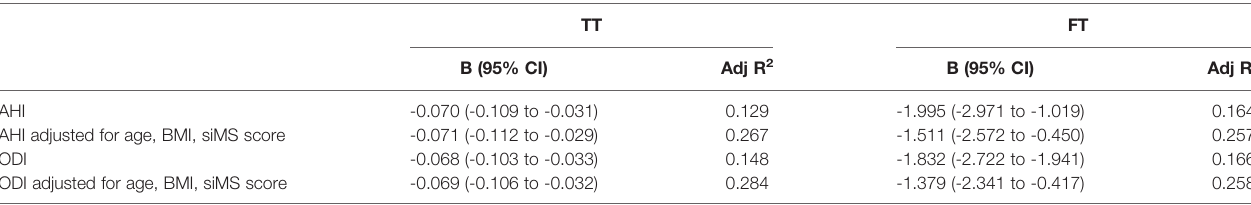
TABLE 4 | Multiple linear regression model for prediction of total testosterone (TT) and free testosterone (FT) for patients with BMI ≥ 40 kg/m 2 .